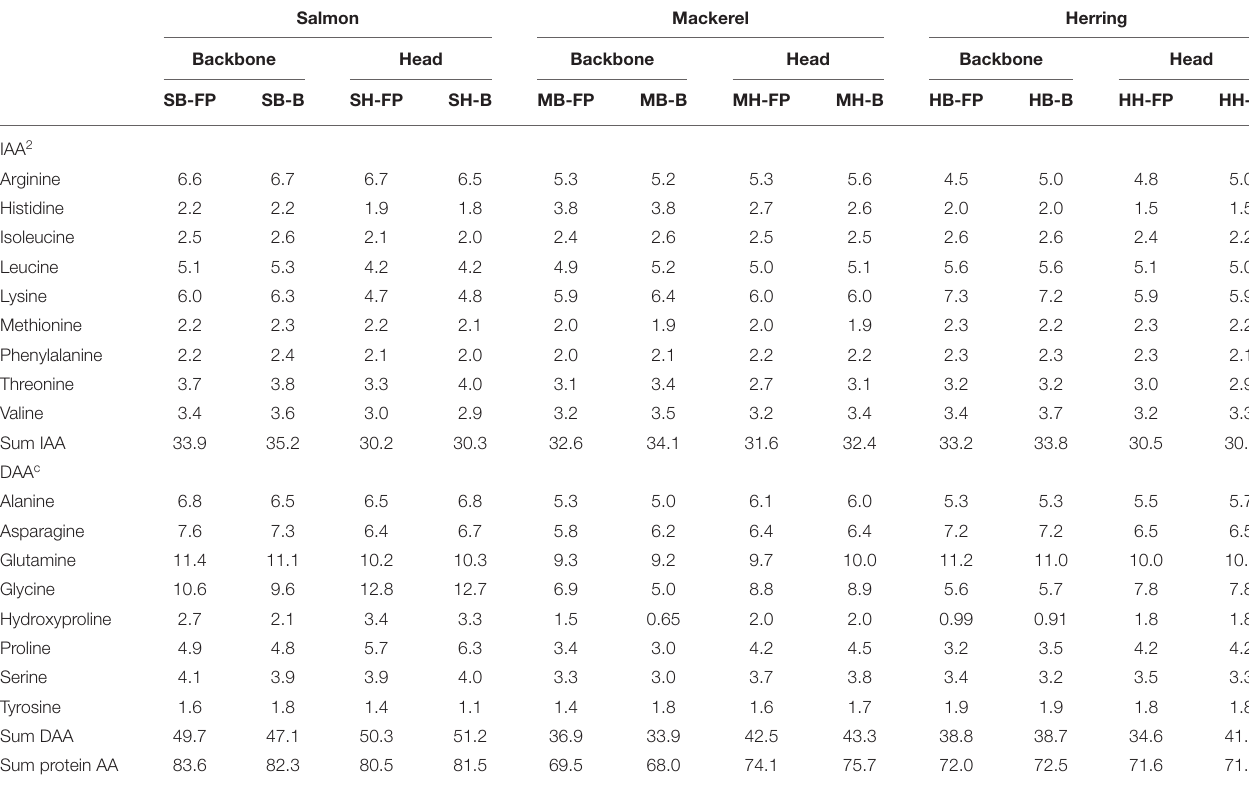
TABLE 3 | Proximate composition (g/100g) of protein hydrolysates based on salmon (S), mackerel (M), and herring (H) backbones (B) and heads (H) using enzymes Food Pro (-FP) and Bromelain (-B) a . Salmon Mackerel Herring Backbone Head Backbone Head Backbone Head SB-FP SB-B SH-FP SH-B MB-FP MB-B MH-FP MH-B HB-FP HB-B HH-FP HH-B Protein 92.1 91.4 92.3 83.0 Dry matter 97.0 95.0 Ash